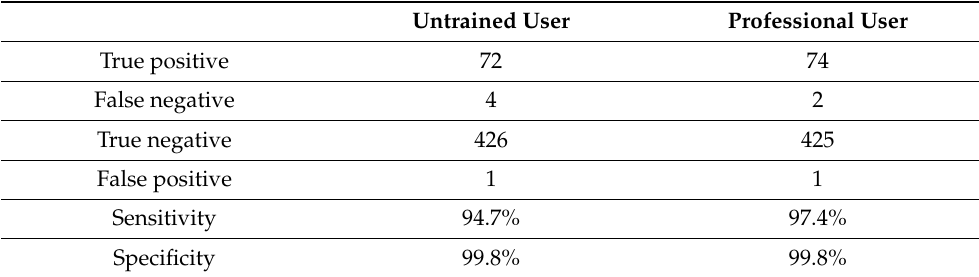
Table 5. Comparison of sensitivity and specificity calculations of user interpretation of ST Results.